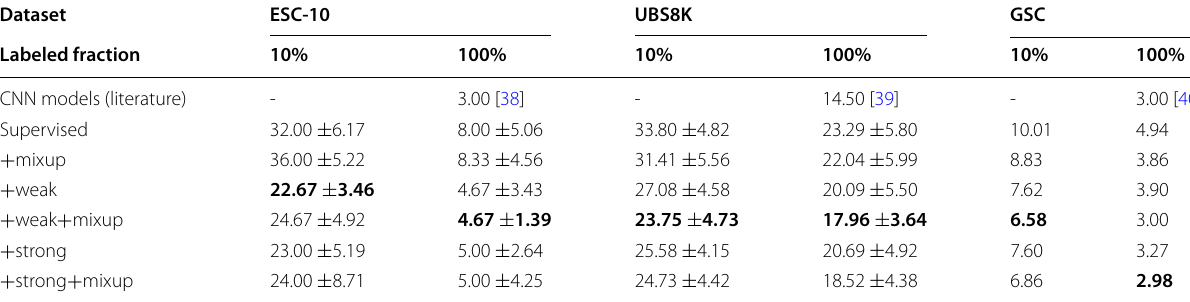
Table 4 Supervised learning Error Rates (%) on ESC-10, UBS8K, and GSC Dataset